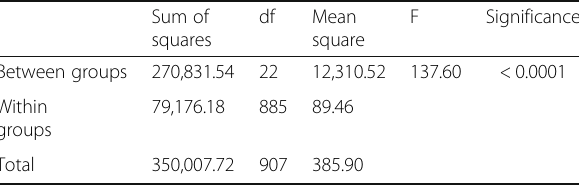
Table 3 One-way ANOVA test shows a highly significant difference ( p < 0.0001) between the torque angle values of